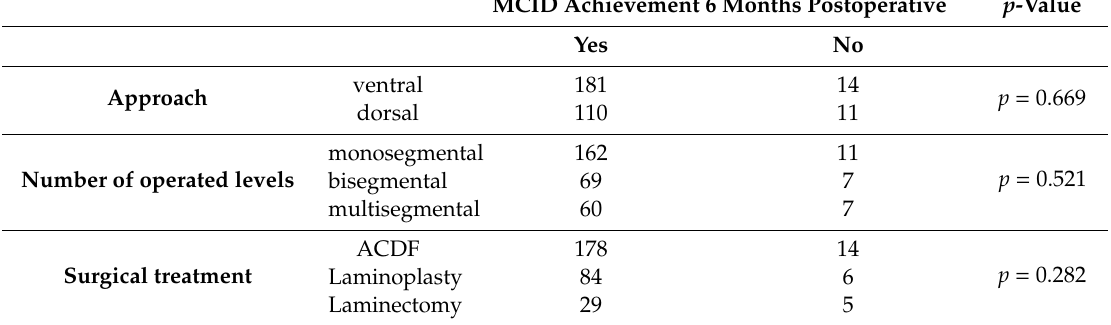
the surgical approach, the number of operated levels, and the surgical treatment; anterior cervical discectomy and fusion: